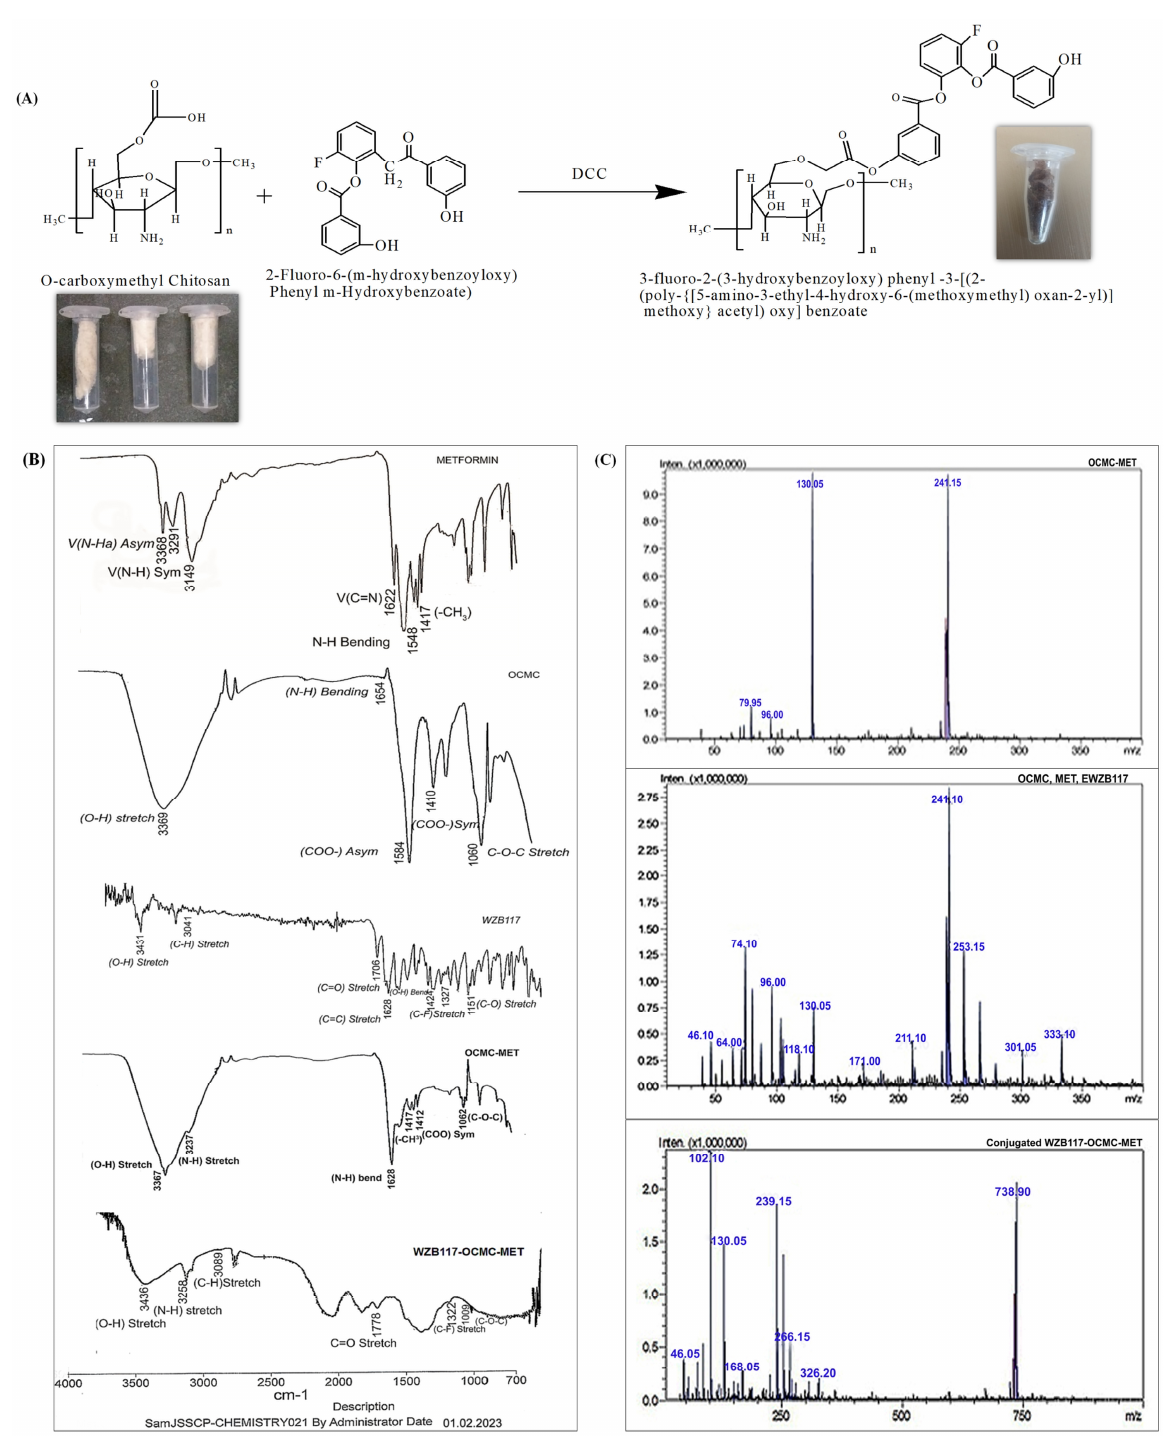
Figure 3. ( A ) Synthesis scheme of WZB117-OCMC-MET by a mono-esterification process to conjugate WZB117 on the surface of OCMC-MET. ( B ) FTIR spectrum Metformin, OCMC, WZB117, OCMC-MET, and WZB117-OCMC-MET to confirm the conjugation. ( C ) Mass spectroscopy of MET, OCMC, WZB117, and the WZB117-OCMC-MET conjugated formulation to confirm the conjugation process.